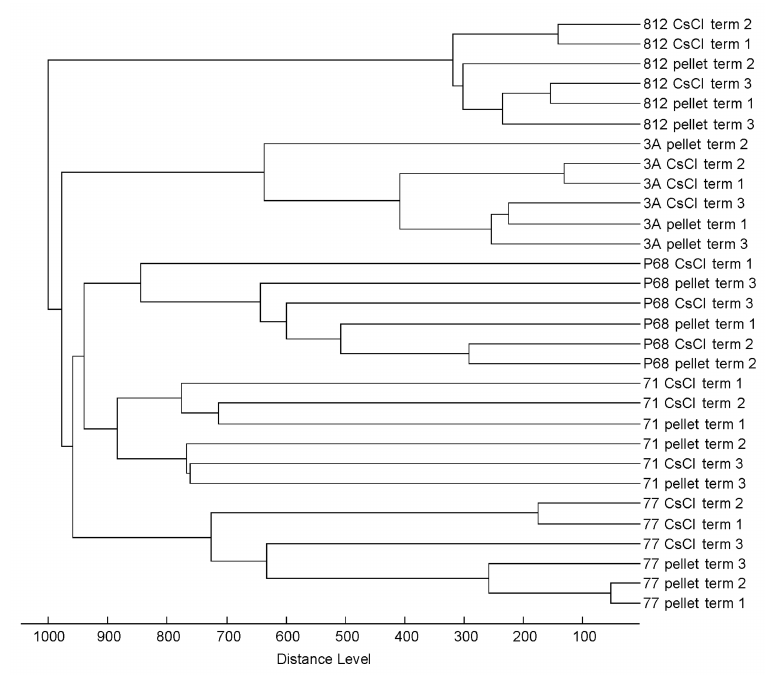
Figure 2. Cluster analysis based on matrix-assisted laser desorption ionization-time-of-flight (MALDI-TOF) mass spectra of three independent analyses of five phage strains prepared by CsCl density gradient centrifugation and pellet